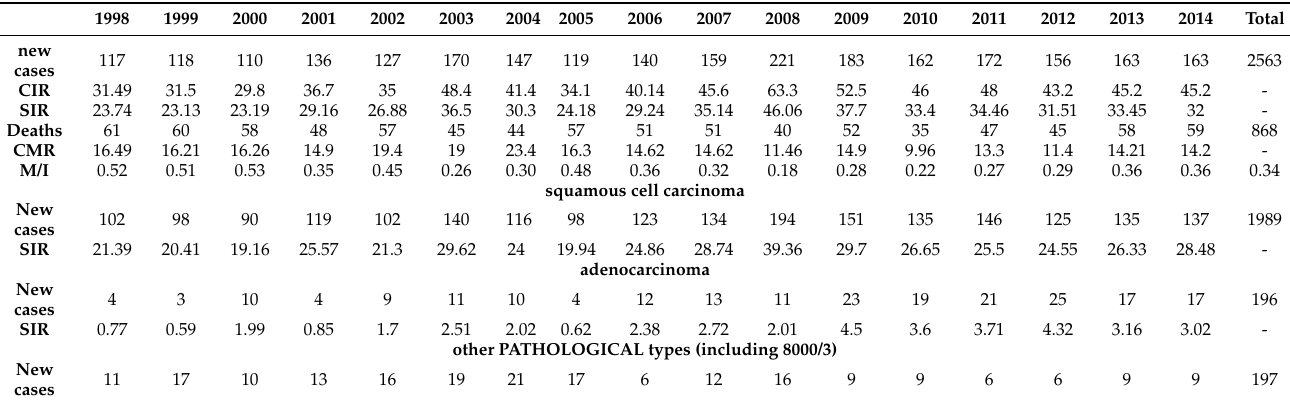
Table 1. Annual incidence and mortality rates from cervical cancer, Cluj County, 1998–2014.